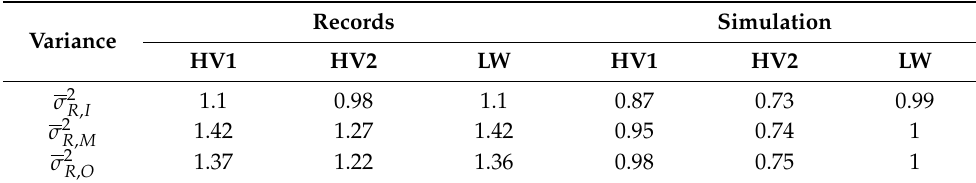
Table 3. Averaged NPLVs for different